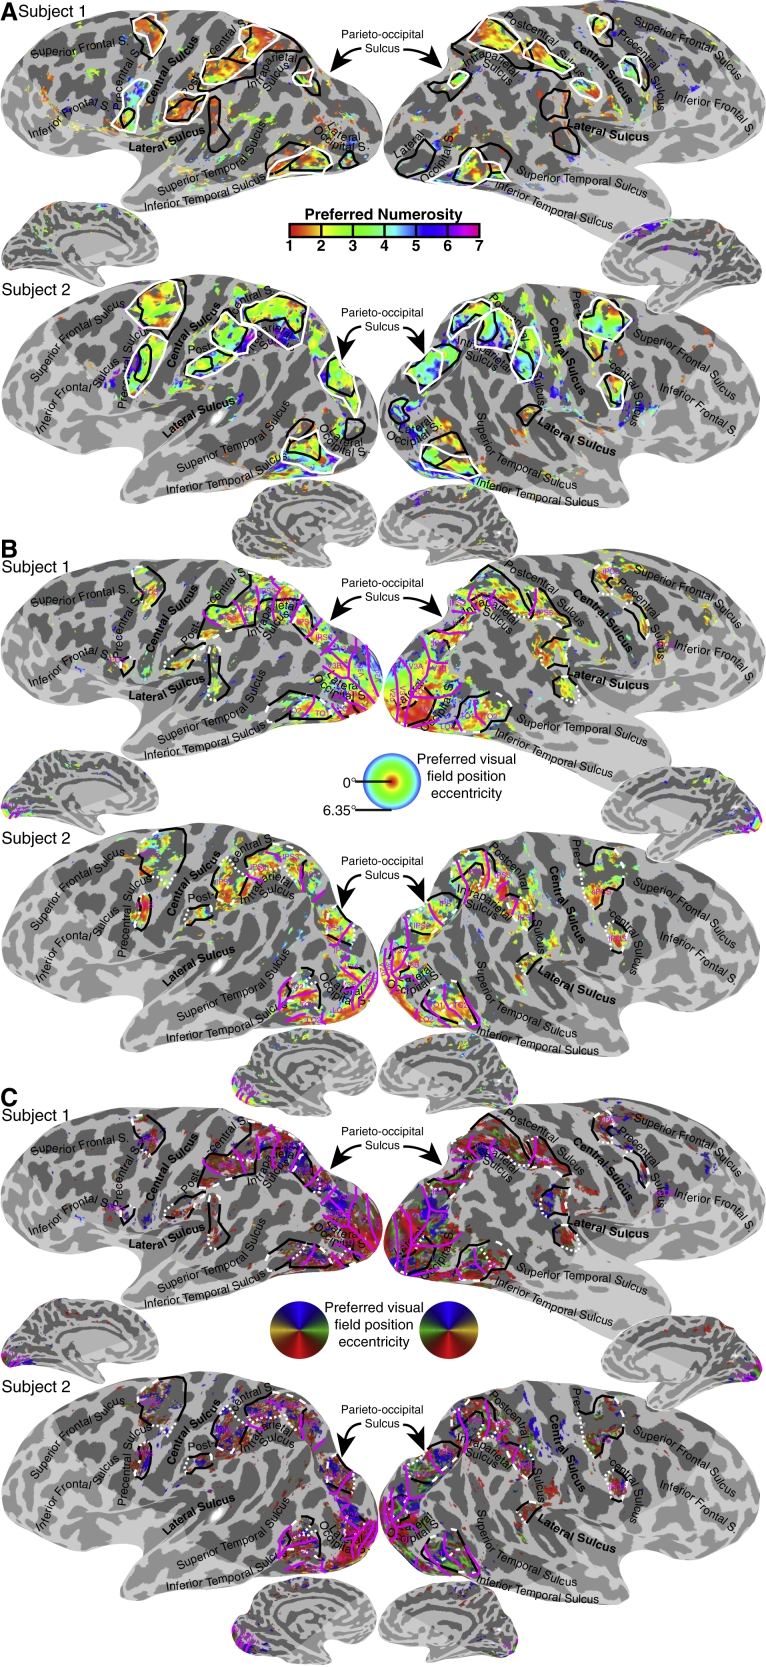
Numerosity and Visual Field Position Preferences(A) Numerosity preferences for recording sites with over 25% response variance explained by the response model. Numerosity maps (white outlines) overlap considerably with timing maps (black outlines). See also Figure S5.(B) Eccentricity preferences for recording sites with over 10% response variance explained by the response model. Timing map locations (black and white outlines) largely fall within the visual field map hierarchy. Visual field map borders are shown as magenta lines, and named in magenta text. See also Figure S6.(C) Polar angle preferences. See also Figure S7.